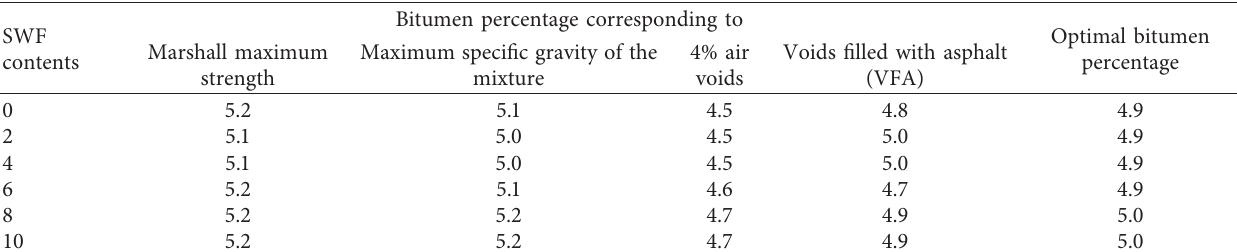
Table 3: The optimal bitumen percentage of samples.